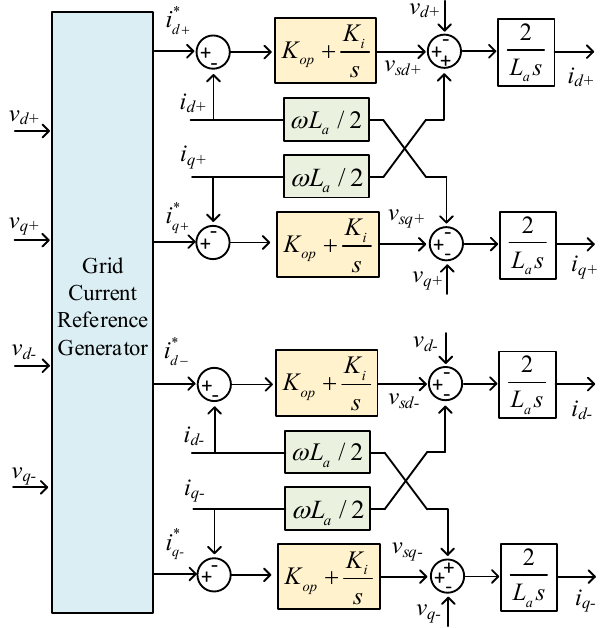
Figure 4. Positive- and negative-sequence current control of the MMC.